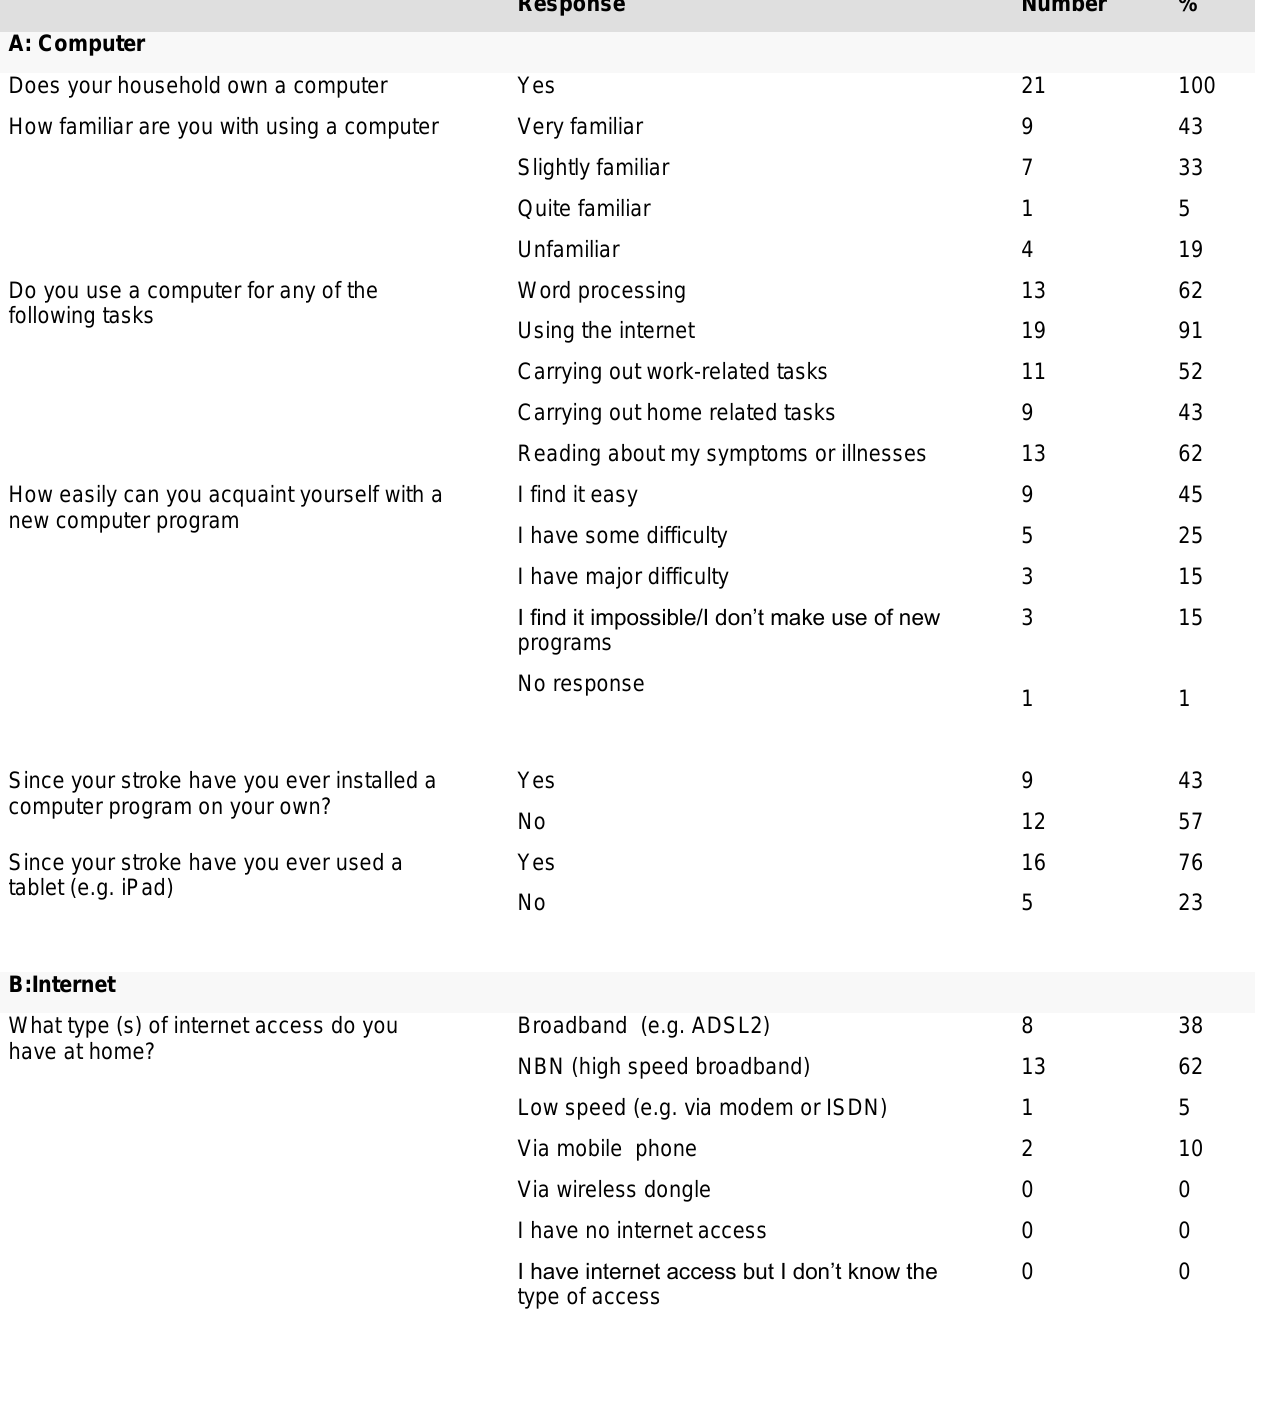
Supplementary Table 1. Technical Familiarity Questionnaire – Summary of responses